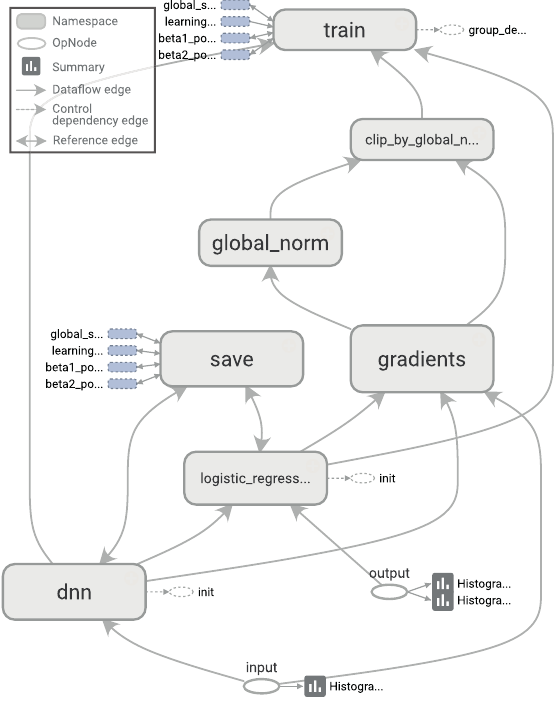
Figure 5. Architecture of a TensorFlow graph for training a deep neural network, generated with TensorBoard.